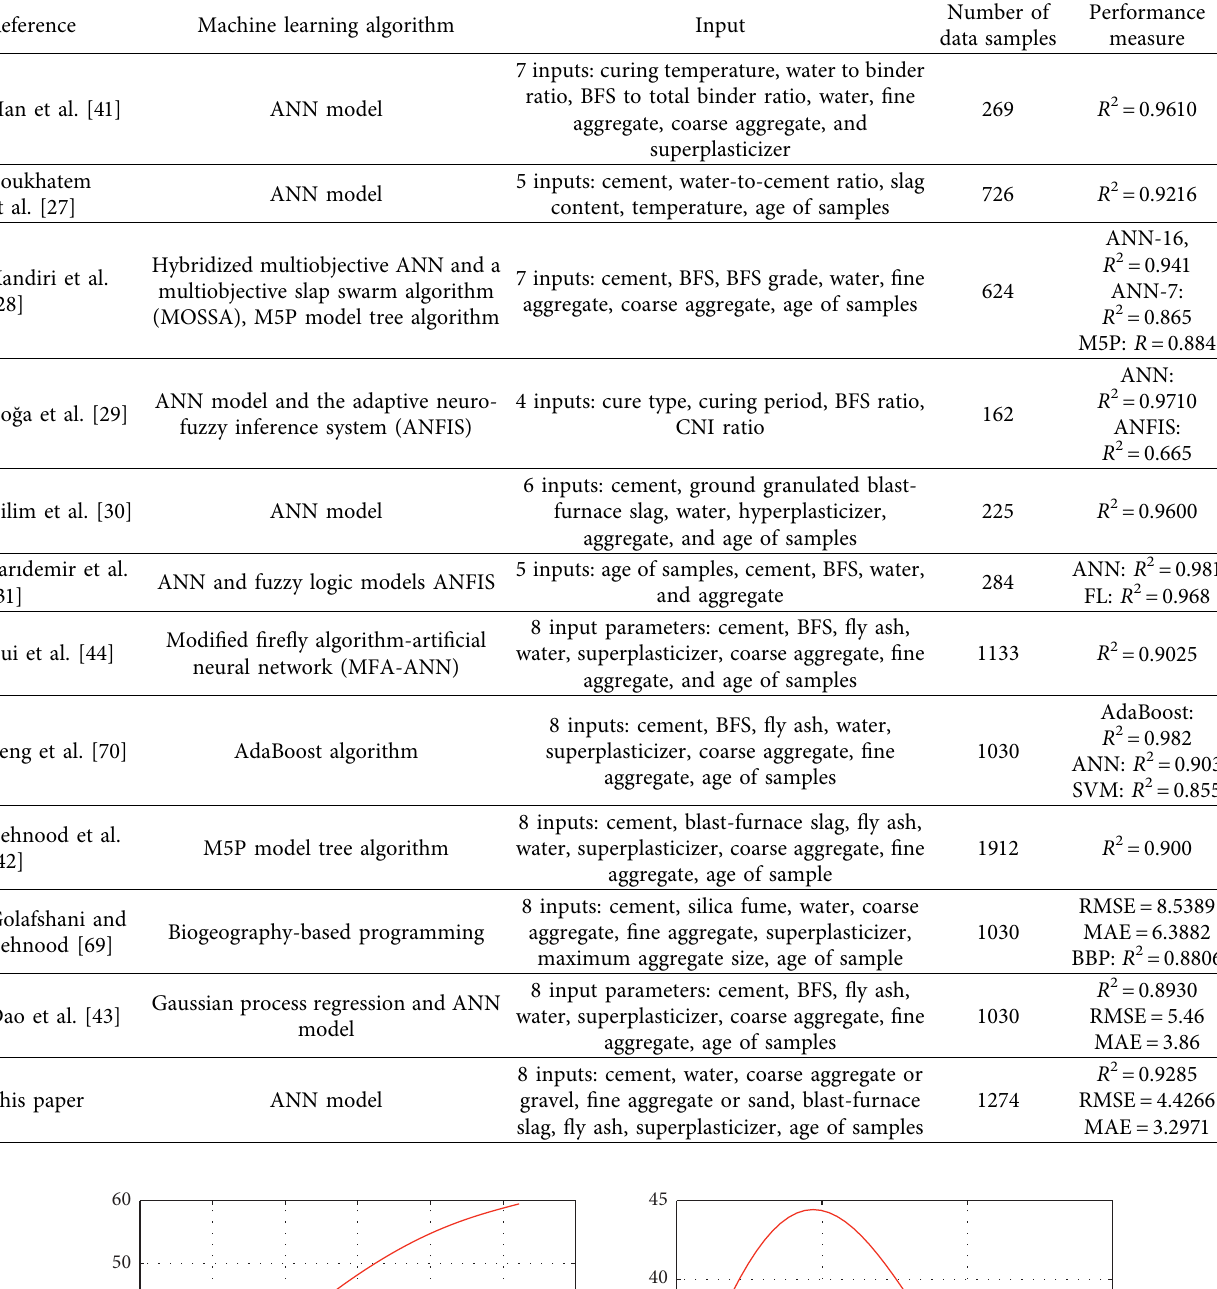
Table 6: Comparison of different machine learning models for predicting compressive strength of